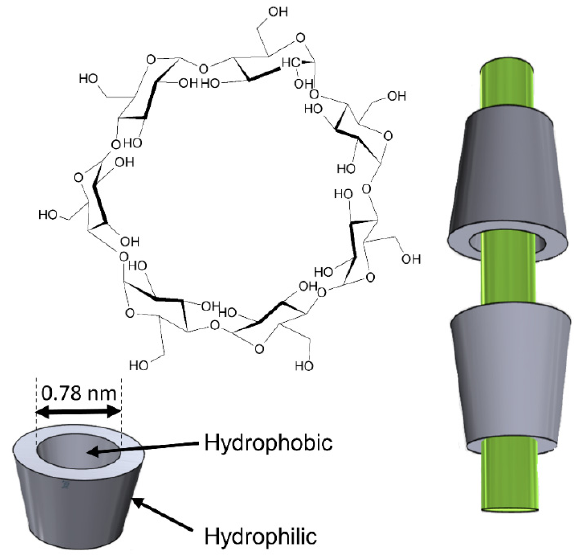
Figure 12. The chemical structure and form of β -cyclodextrin [127].